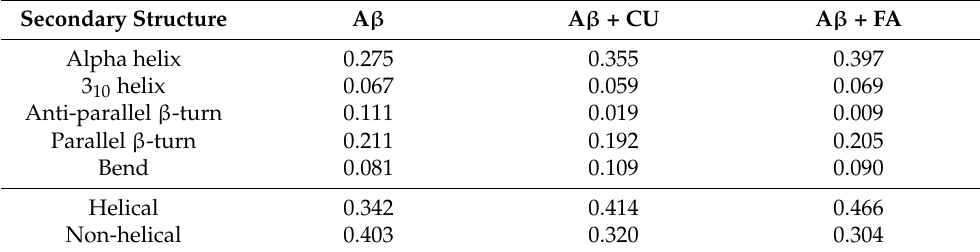
Table 1. Propensities of secondary structures of the modelled systems given as average values over the total 1000 ns (1 µ s). Helical propensity is the sum of α - and 3 10 - helices. Non-helical propensity summarizes parallel and anti-parallel β -turns and bending